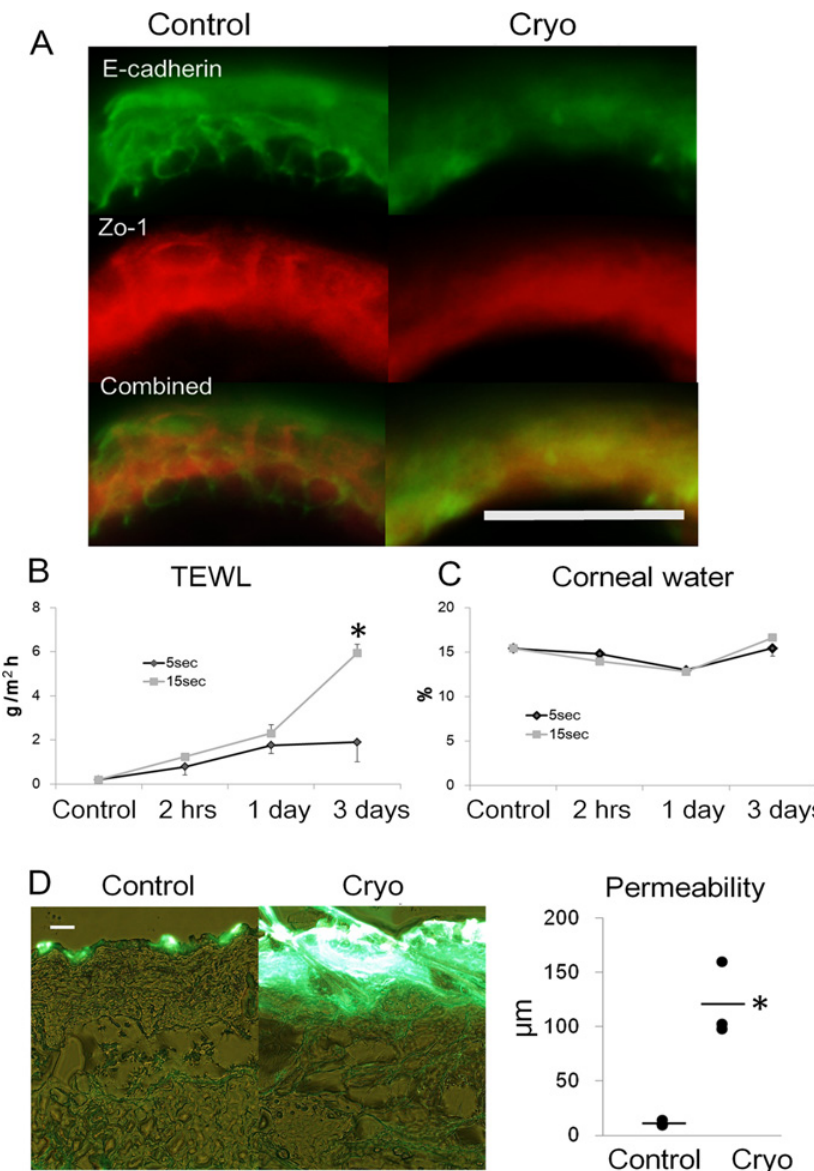
Fig 4. Functional and morphological changes of skin barrier. A) Immunohistochemistry of E-cadherin and Zo-1 after 15-sec cryoablation at day 1. Scale bar, 100 μ m. The change of transepidermal water loss (TEWL, B) and corneal water content C). D) Increased skin permeability of lucifer yellow after 15-sec cryoablation at day 1. Green fluorescence shows the permeation of lucifer yellow. Cryo, cryoablation; scale bar, 100 μ m; and sec, seconds. Values represent the mean ± SEM (B, C). Data are shown as dots (D). Bars represent the mean values. Significant differences between the means are indicated, * P < 0.05 versus 5 sec in (B) and control in (D). n = 4, in each group of (B) and (C). n = 3, in each group of